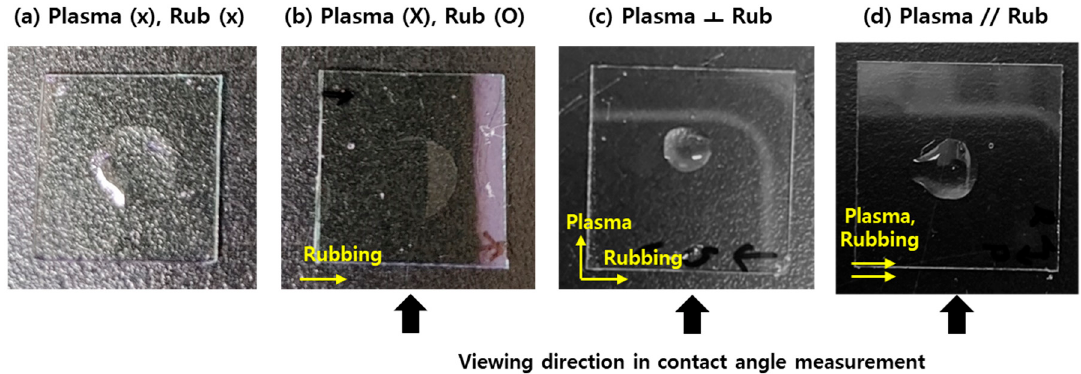
Figure 9. Photograph of water droplet on the PVA-coated surface. ( a ) No plasma treatment and no rubbing, ( b ) no plasma but rubbing ( c ) plasma treatment perpendicular to the rubbing, ( d ) plasma treatment parallel to the rubbing. The photograph was taken 5 min after the water was dropped. Black arrows correspond to the viewing direction in the contact angle measurement.